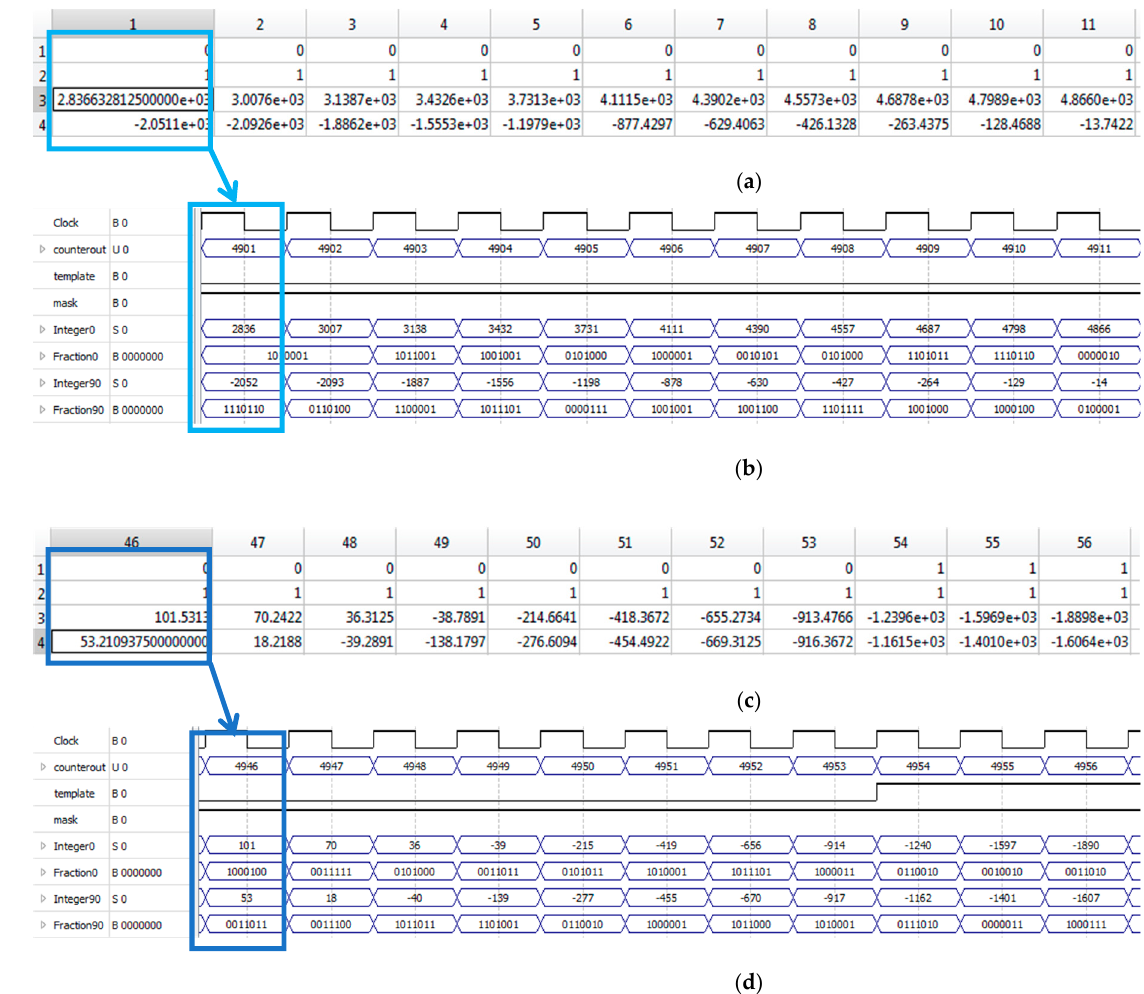
Figure 14. Simulation results of the 2D convolution (filtering) module: ( a ) Results from the software implementation of the filters; ( b ) corresponding results from the proposed hardware architecture showing one output per clock cycle; ( c ) results from the software implementation of the filters (another set of pixels); ( d ) corresponding results from the proposed hardware architecture showing one output per clock cycle.